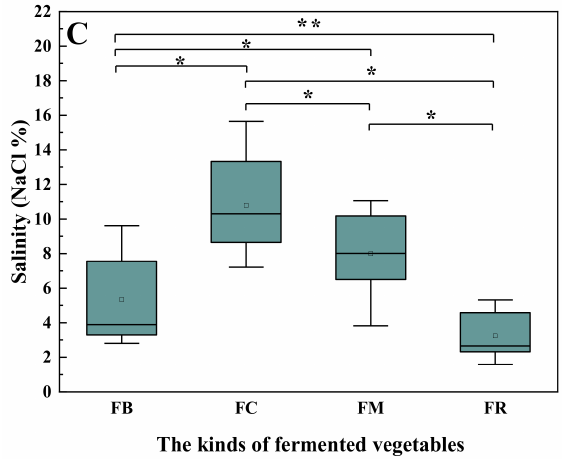
Figure 1. Physicochemical characteristics of different types of fermented vegetables: ( A ) pH, ( B ) titratable acidity, and ( C ) salinity. FB, fermented bamboo; FC, fermented cabbage; FM, fermented mustard; FR, fermented radish; * indicates significantly different means at p < 0.05; ** indicates significantly different means at p < 0.01.